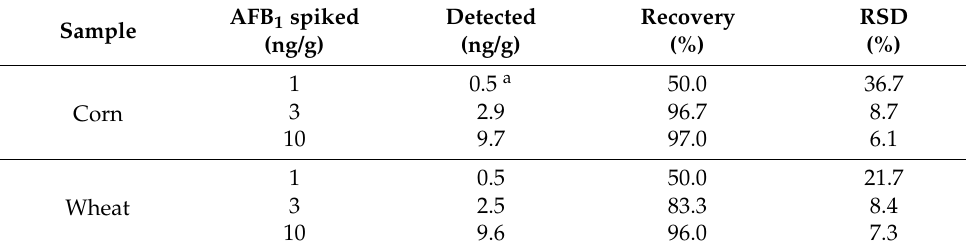
Table 2. Recovery results of spiked samples using the Apt-strip.